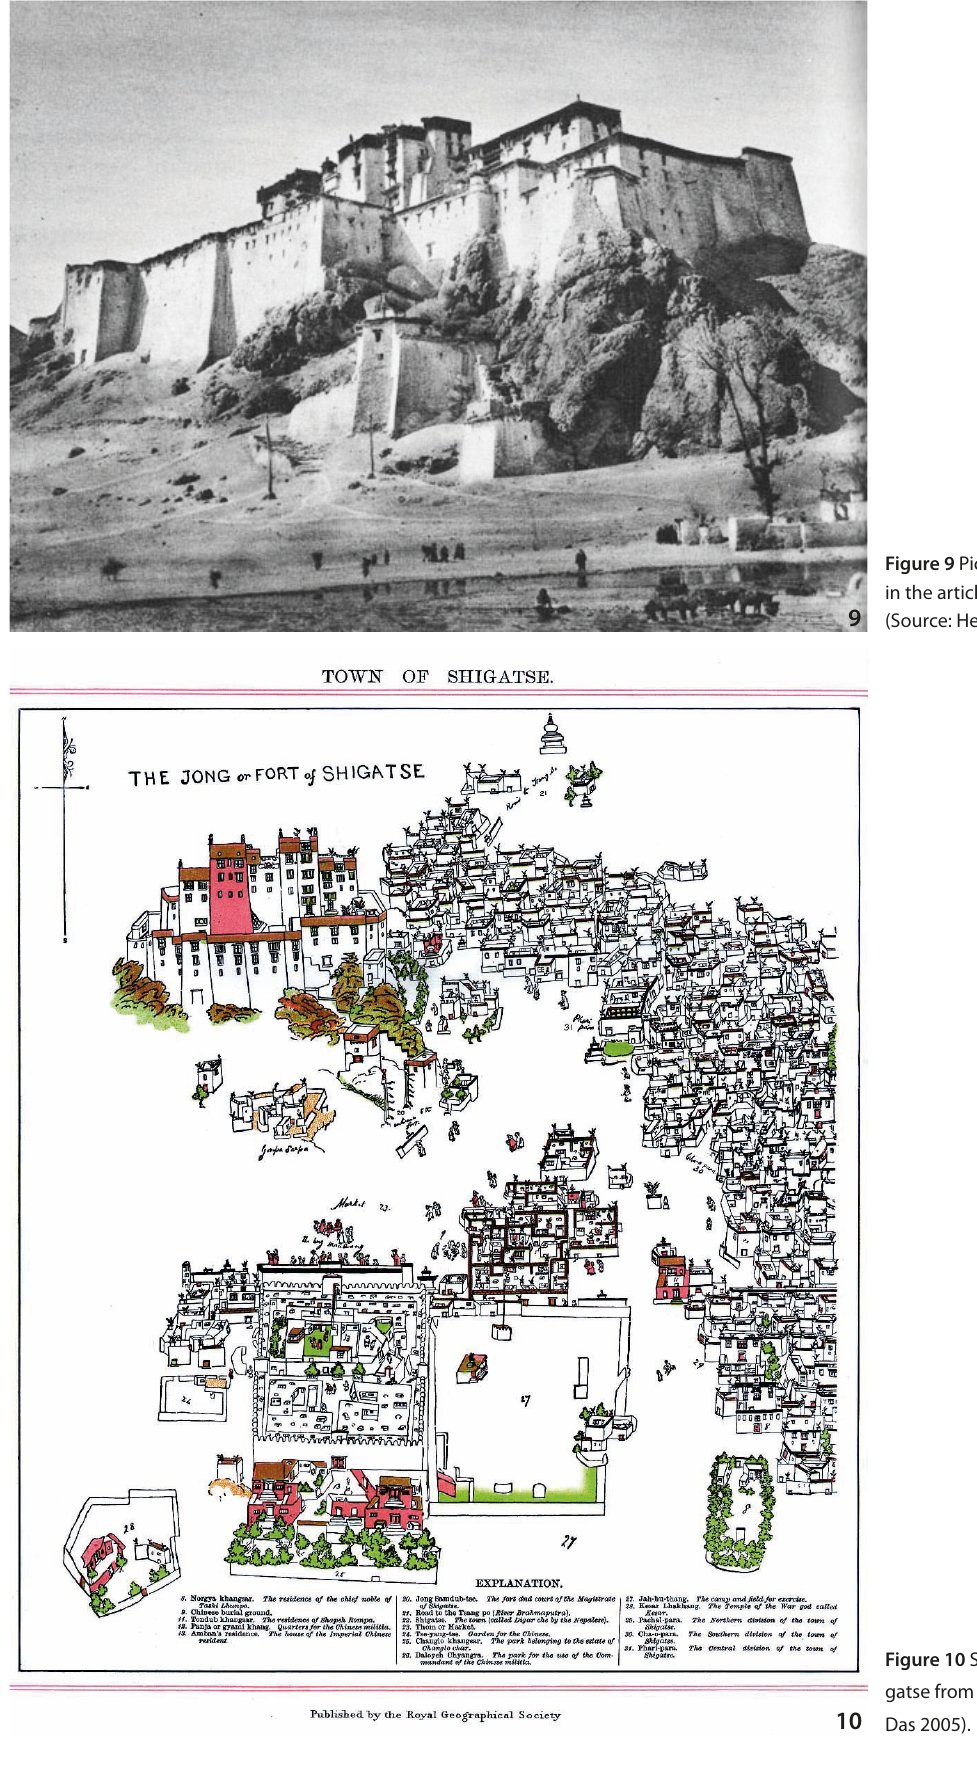
Figure 10 Sangzhutse Fortress in Shi- gatse from a drawing in 1902 (Source: Das